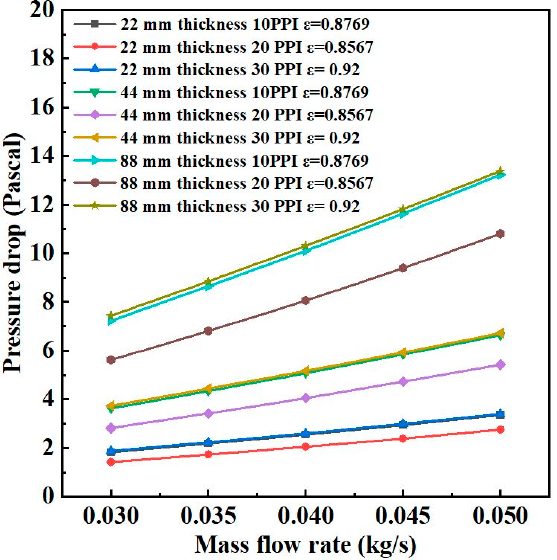
Figure 12. Variation of pressure drop for different mass flow rates for different PPI and different thicknesses.